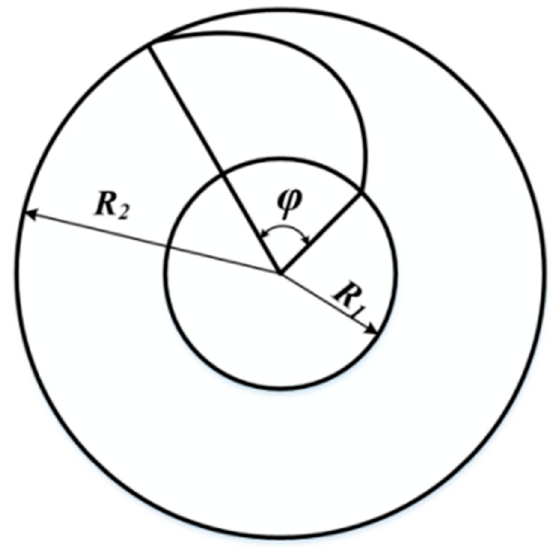
Figure 6. Schematic diagram of blade wrap angle.